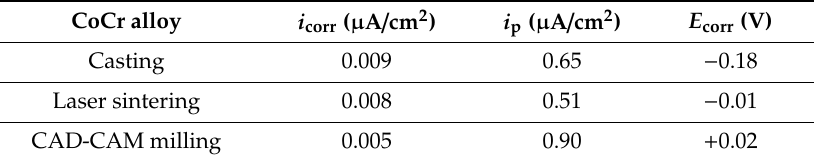
Table 3. Corrosion parameters